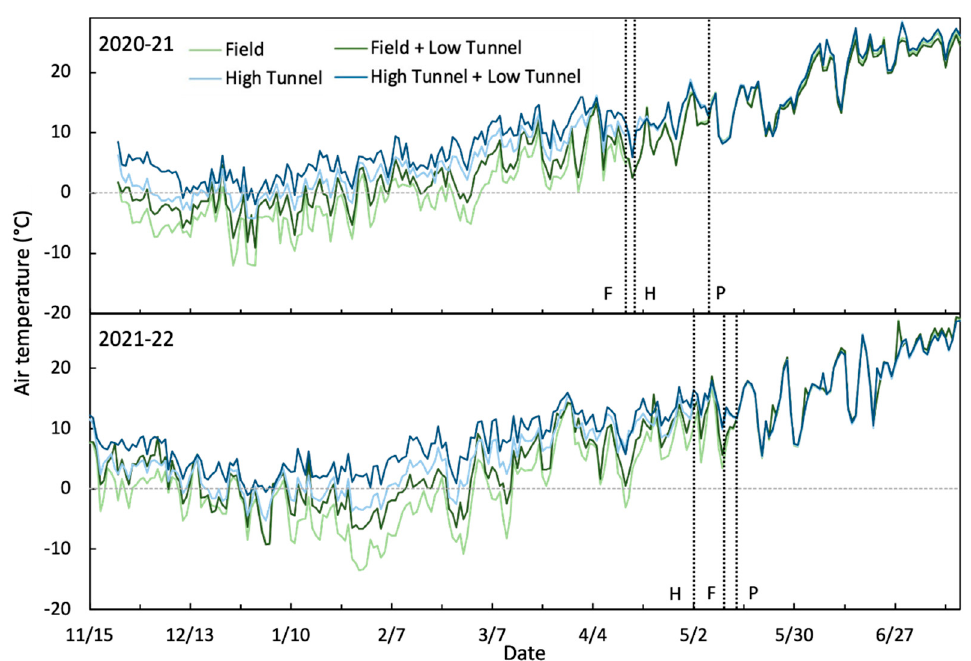
Figure 2. Average daily air temperature (0.25 m) in 2020-21 (top) and 2021-22 (bottom) in an uninsulated field (light green line), a field covered with low tunnels (dark green line), a high tunnel (light blue line), and a low tunnel within a high tunnel (dark blue line) in North Logan, UT. Vertical dashed lines marked with F, H, and P denote the dates on which field low tunnels, high tunnel low tunnels, and high tunnel plastic were removed, respectively.